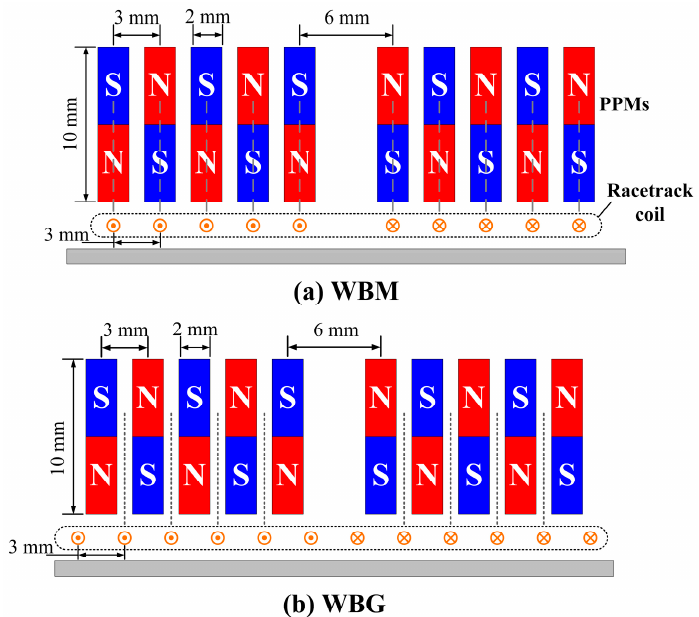
Figure 16. Structure diagrams of the WBM and WBG EMATs in experiments.